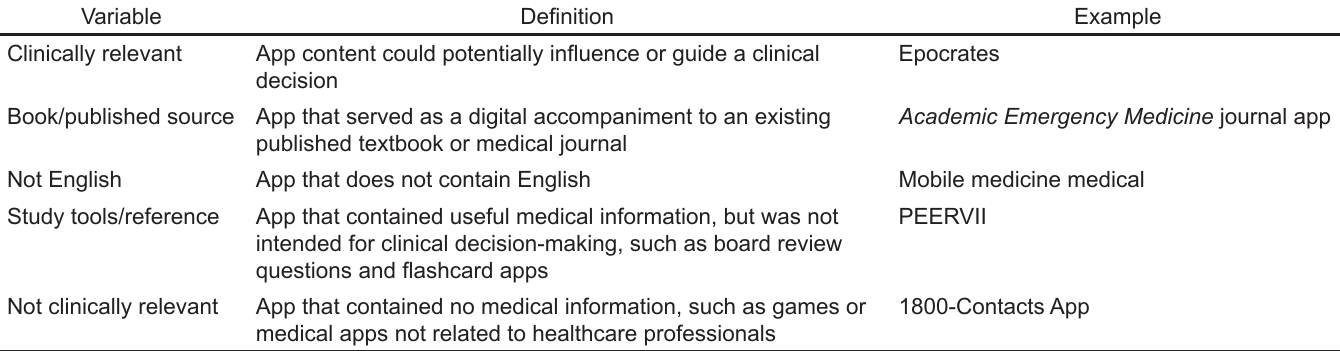
Table 1. Definition of the variables used for categorization of iTune medical apps.